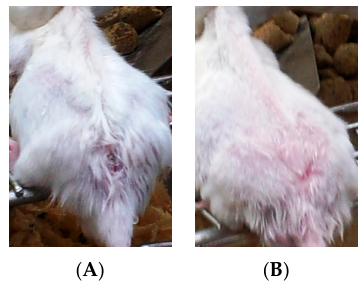
Figure 4. ( A , B ) Cutaneous leishmaniasis scars of BALB/c mice disappeared after treatments (four weeks post infection), with allicin and Cip.